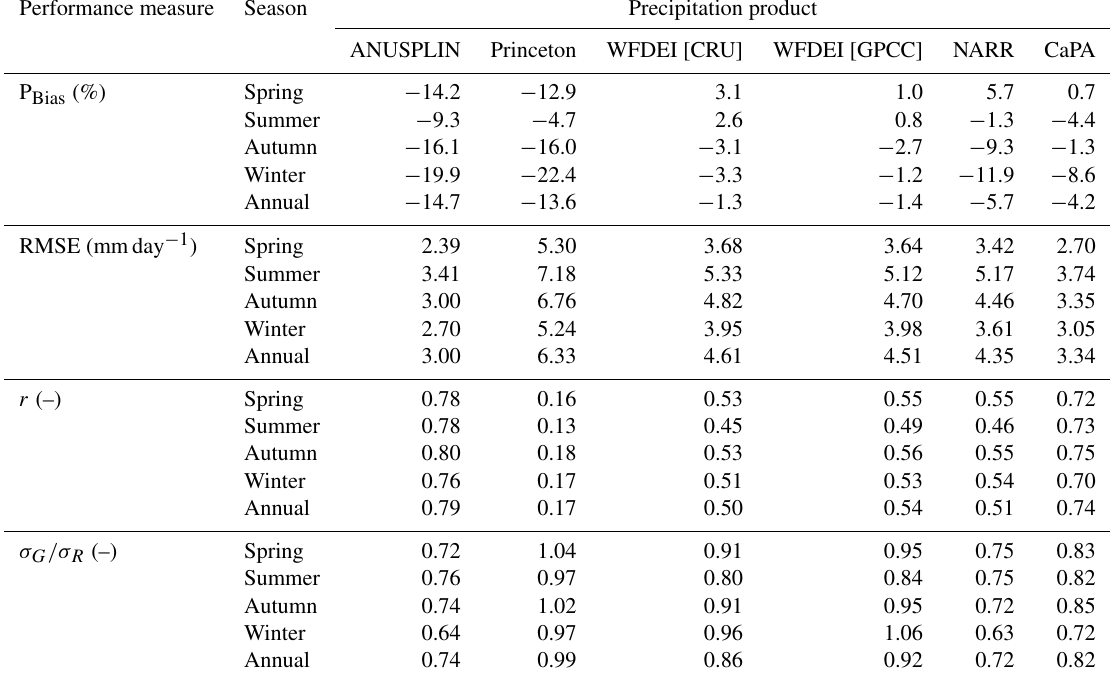
Table 5. Performance measures (accuracy ( P Bias ) , magnitude of the errors (RMSE), strength and direction of relationship between gridded products and precipitation-gauge stations ( r) and amplitude of the variations ( σ G /σ R )) of each type of gridded precipitation products when evaluating against the precipitation-gauge station data over Canada in four seasons for the time period of 2002 to